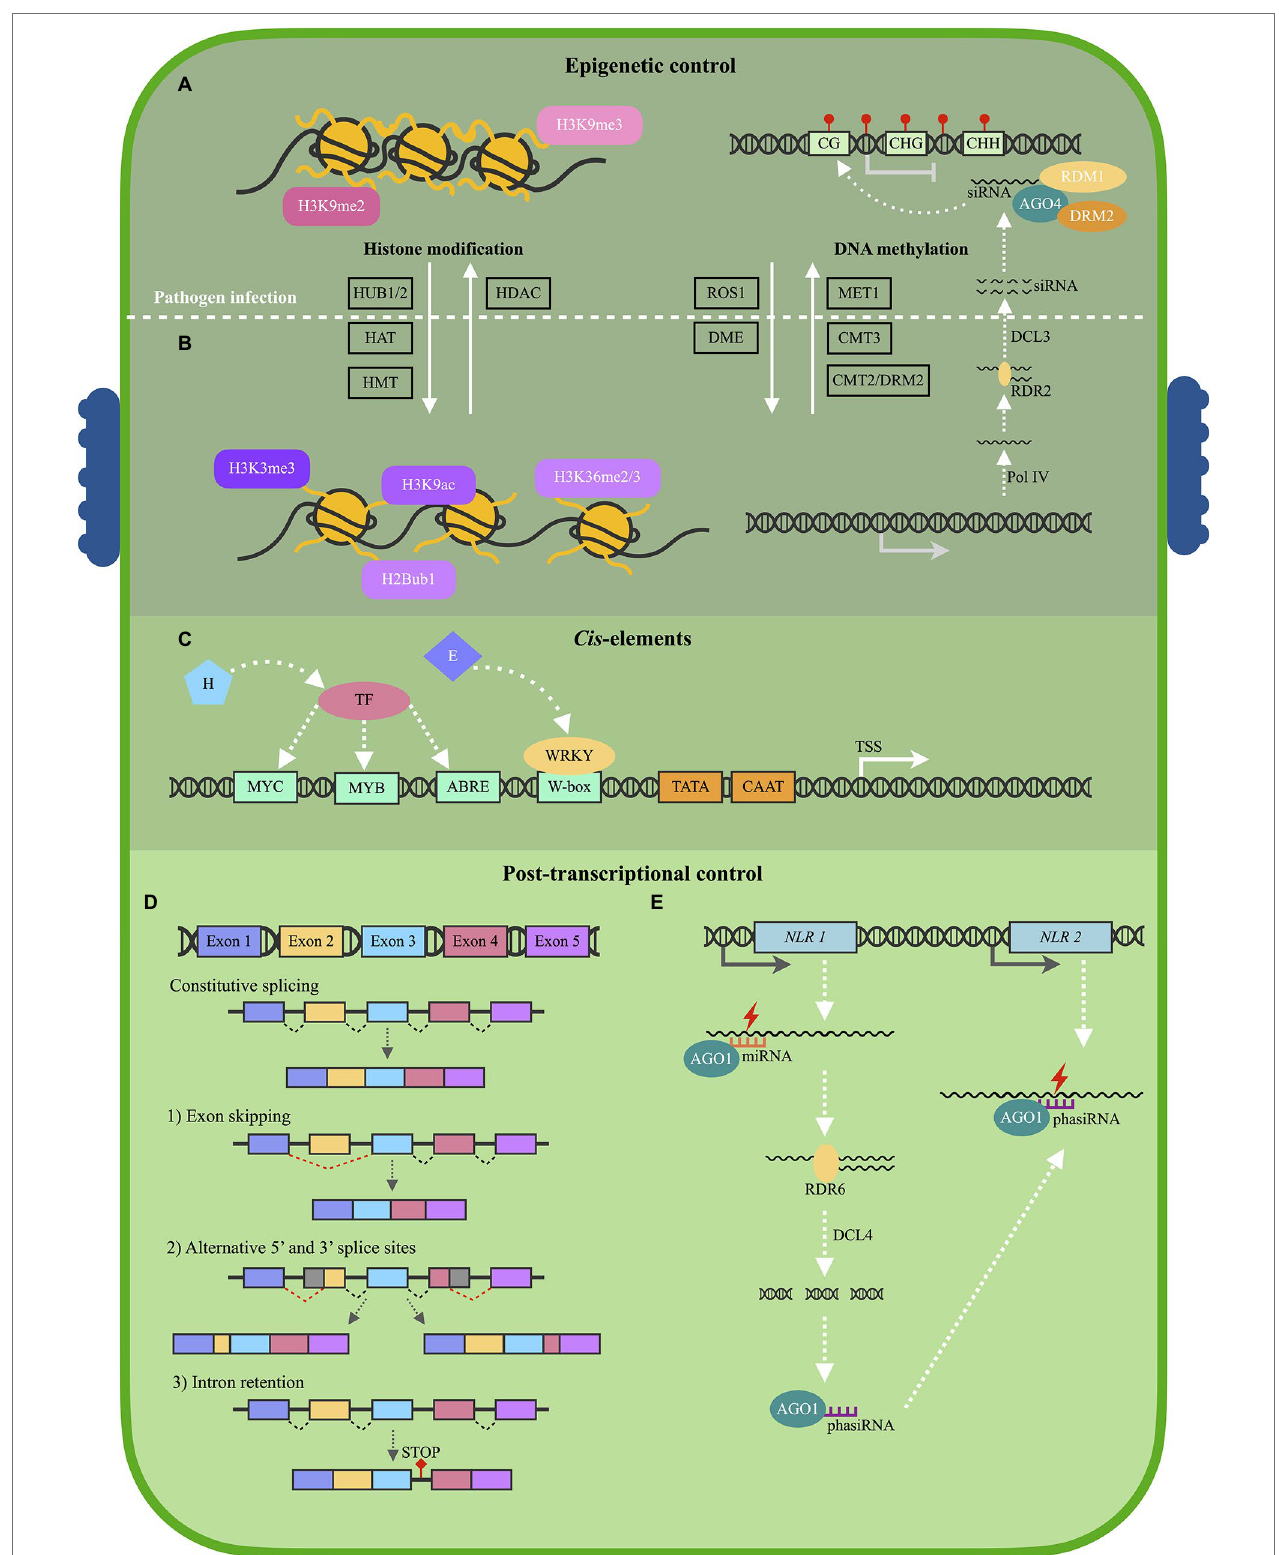
FIGURE 2 | Schematic illustration of the main regulatory mechanisms of plant NLR expression. (A) Before pathogen infection, a heterochromatin structure